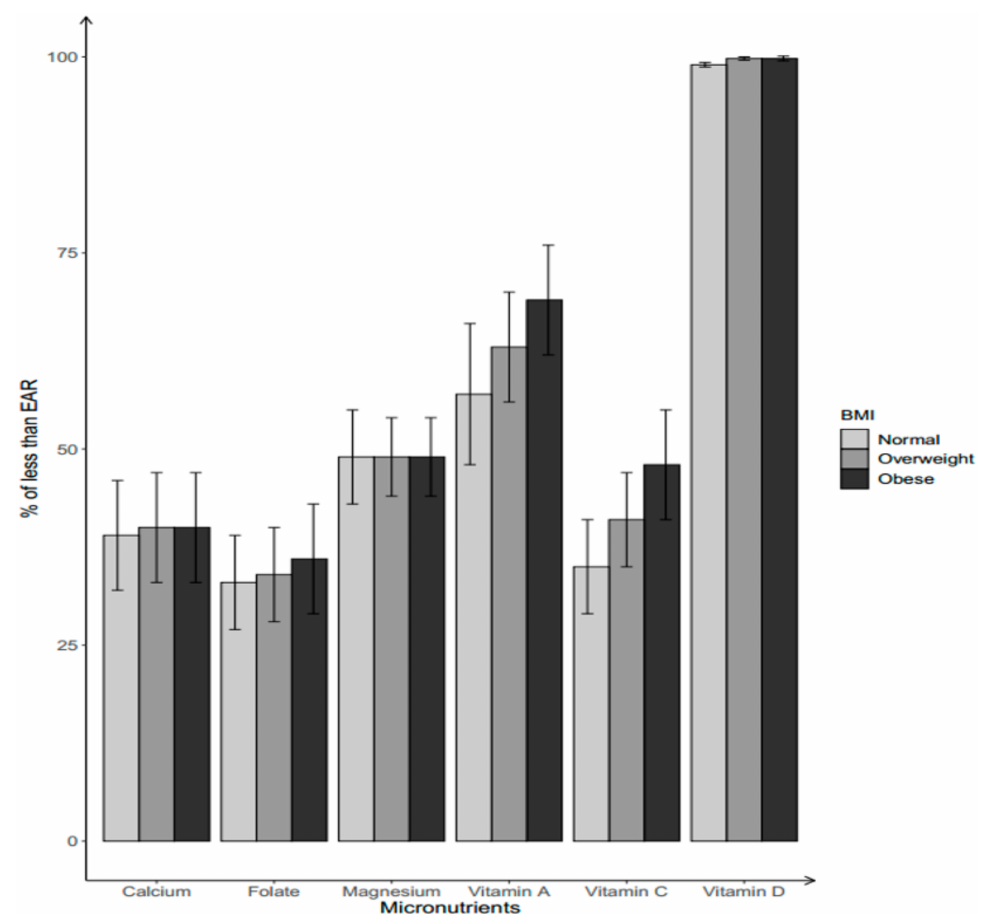
Figure 1. Percentage of Mexican-American women aged 19–39 years with dietary micronutrient intakes below the Estimated Average Requirements (EARs) by body weight status. Body weight status categorized by BMI into three groups: normal / under-weight: BMI ≤ 25.0; overweight: 25.0 < BMI < 29.9; obese: BMI ≥